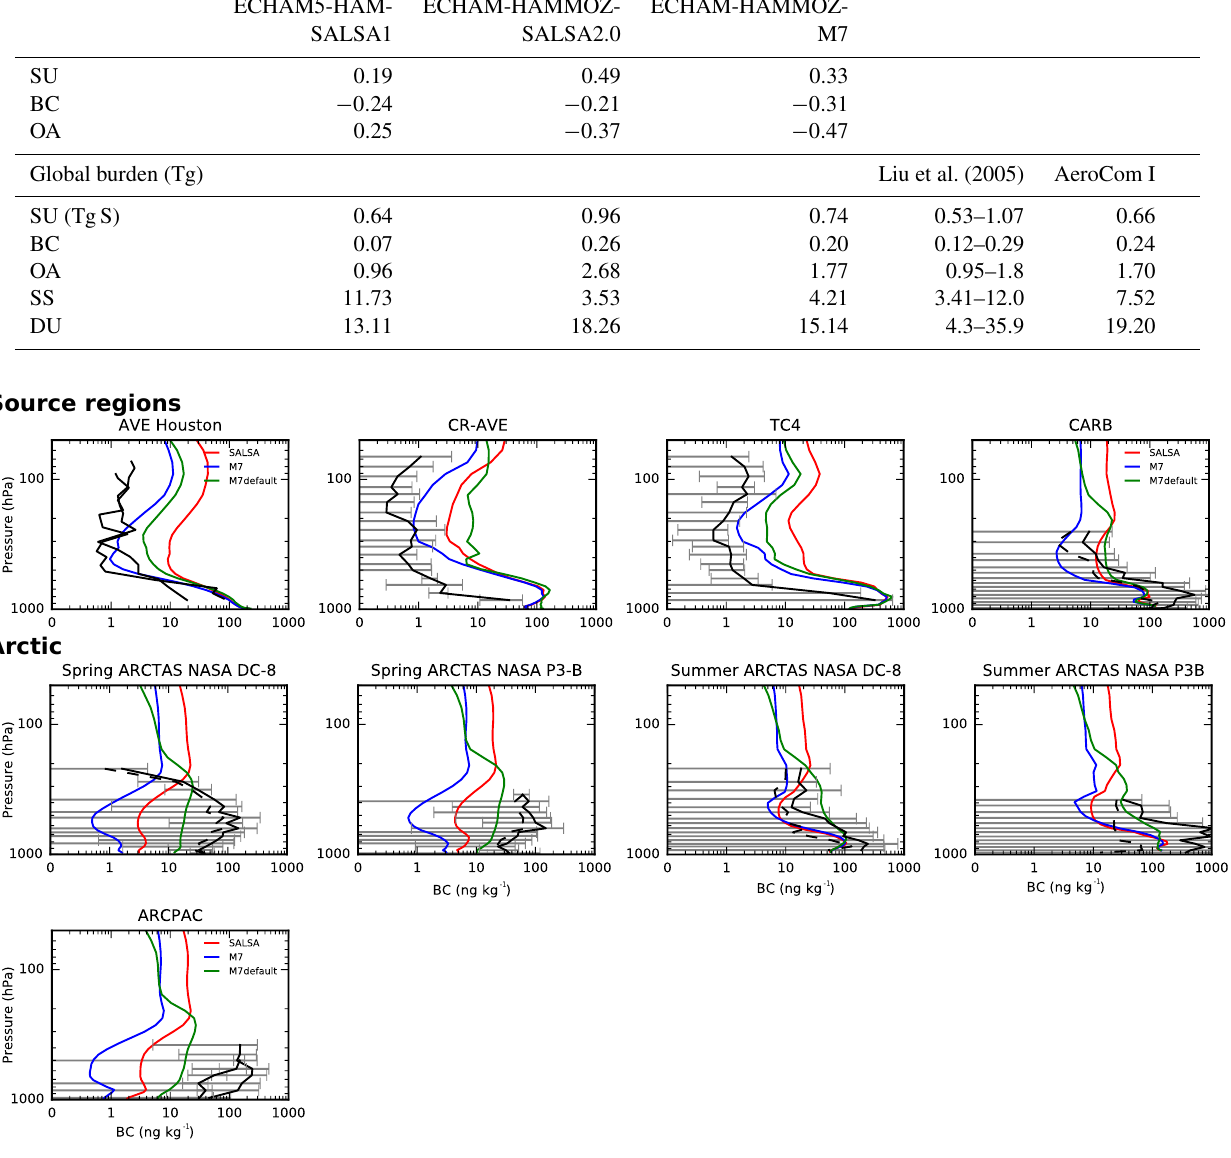
Figure 12. Observed and modeled mean vertical profiles of BC in aircraft measurement campaigns. Black curves represent the measured BC concentrations and the gray whiskers show the variability in